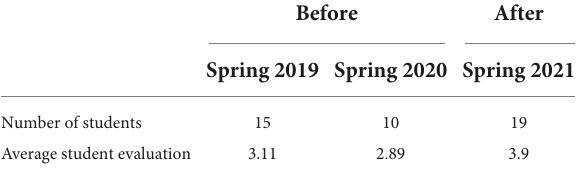
TABLE 5 Before-after comparison of implementing Excel spreadsheet, CE